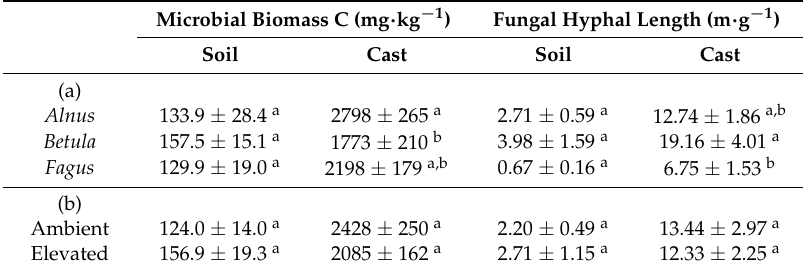
Table 2. Effect of ( a ) litter species and ( b ) CO 2 regime on microbial biomass carbon and fungal hyphal length in the soil and cast aggregates—mesocosm